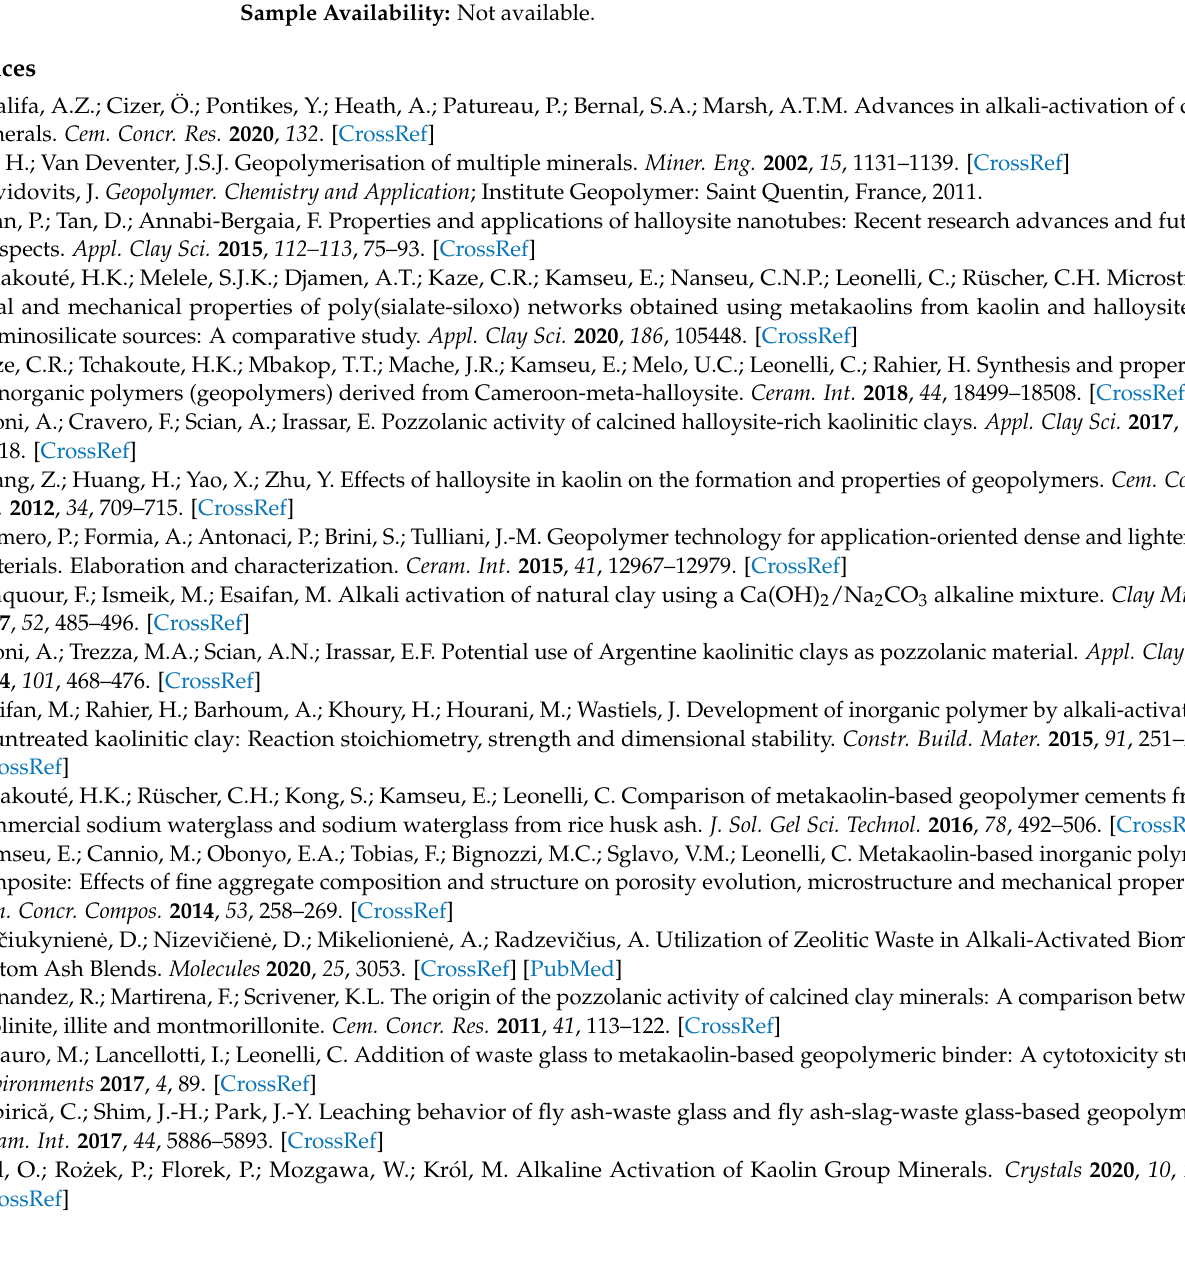
Table S1: Elemental composition (Atom %) from EDS analysis of KC_NF and KC_NF